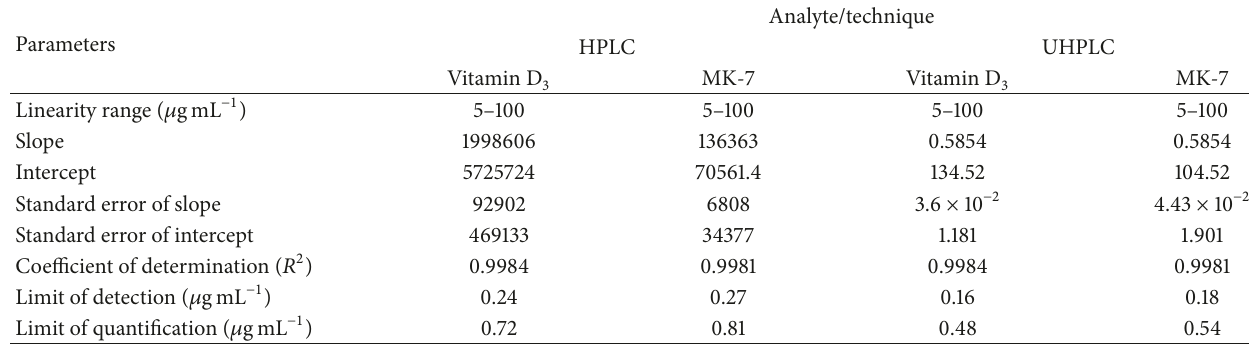
Table 3: Statistical evaluation of regression data of vitamin D 3 and MK-7 by HPLC and UHPLC.